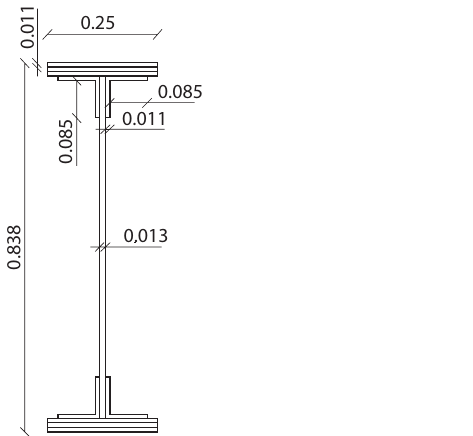
Fig. 3. Geometrical survey of the Meschio Bridge, typical section of the principle beam corresponding to the A–A, B–B, C–C section reported in Fig. 2 (Pipinato